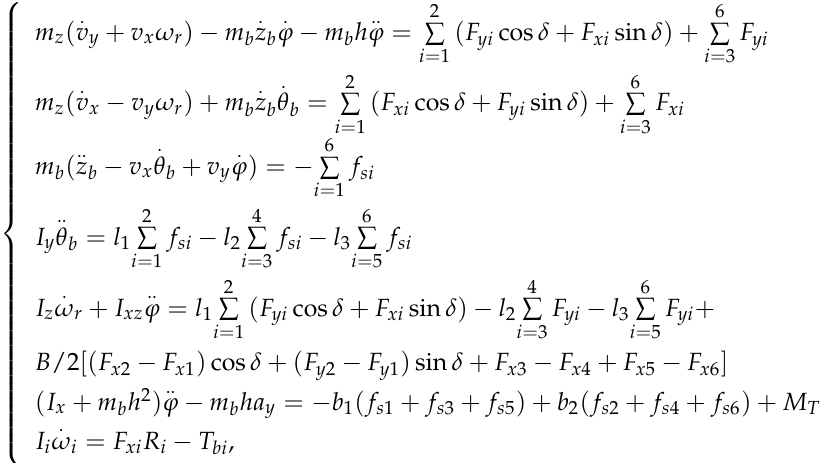
f is the suspension force. where si Based on D’Alembert’s principle, the whole vehicle dynamics Equation (3) is estab- lished.